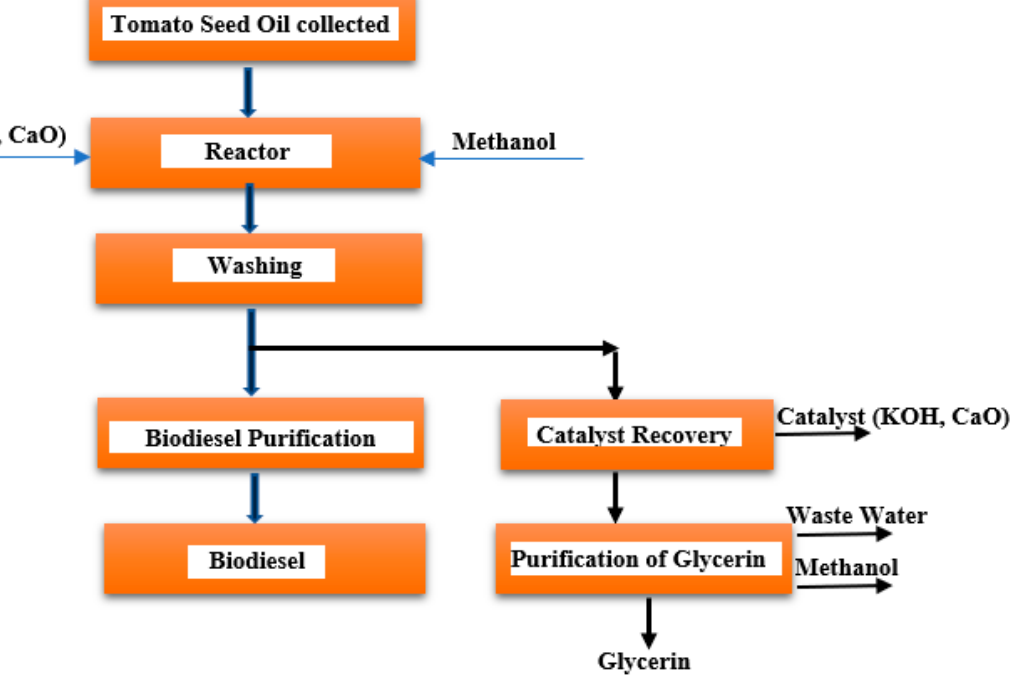
Figure 5. Scheme of the synthesis of biodiesel from tomato seed oil.